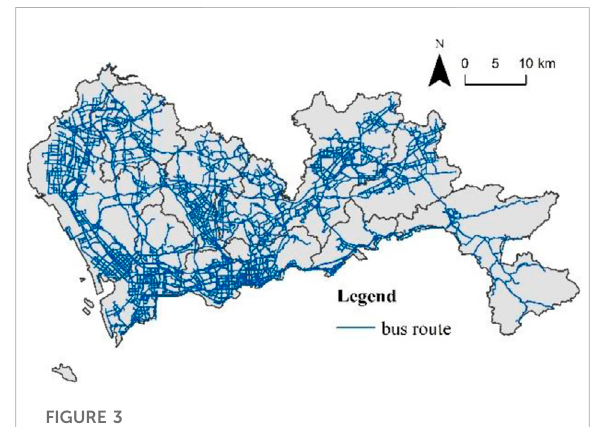
FIGURE 3 Spatial distribution of bus routes in